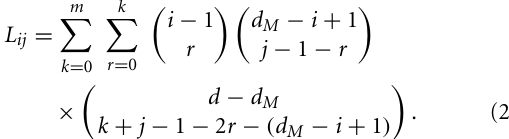
(64). The program code is implemented in C ++ . For small